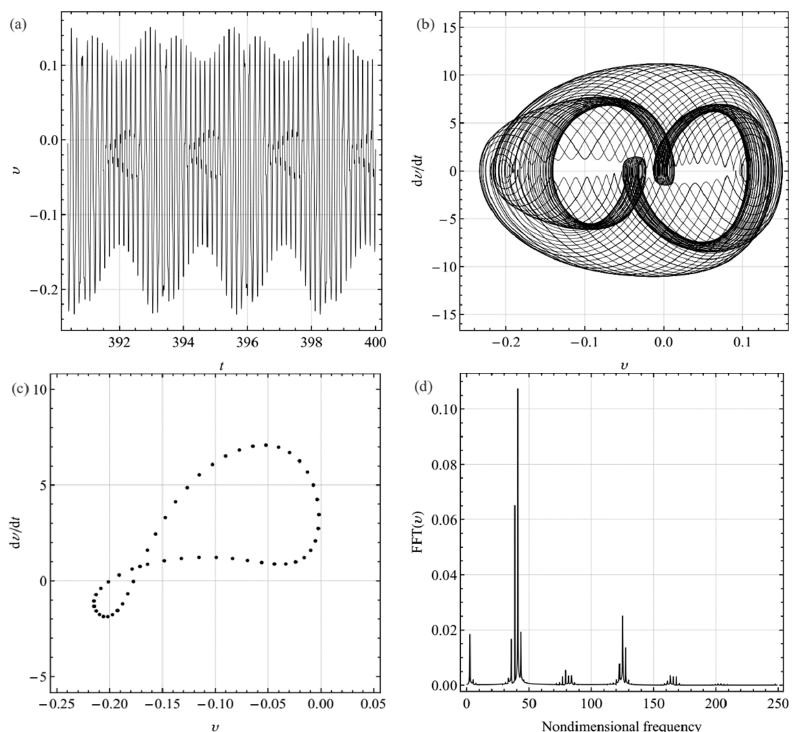
Figure 11. Quasi-periodic response for the excitation frequency ratio Ω = 40.8505 ( σ 2 = −2.0307): ( a ) time history; ( b ) phase-plane portrait; ( c ) Poincare sections; ( d ) Fourier spectrum.